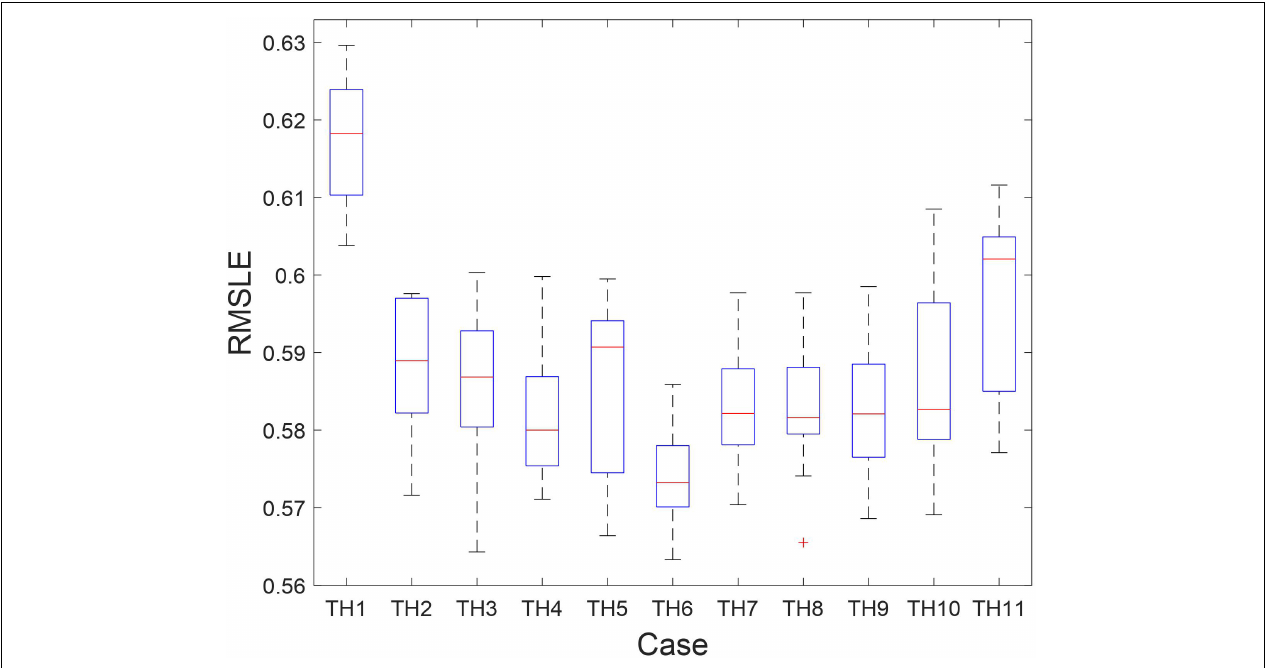
FIGURE 4 | The box plots of the RMSLE of the Cases TH1 to TH11 (using absolute values of time history